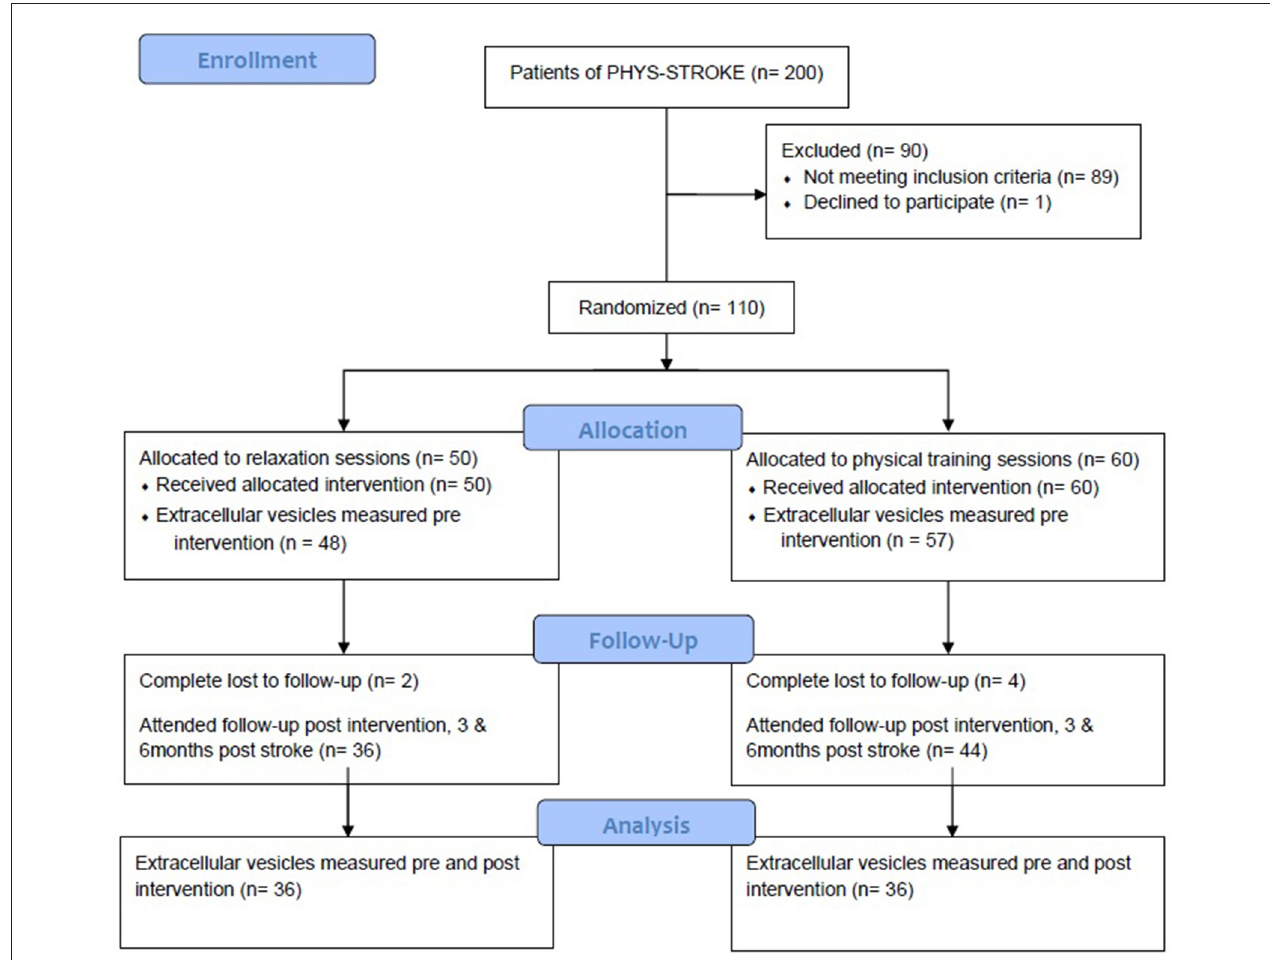
FIGURE 1 | Consort flow diagram for the BAPTISe